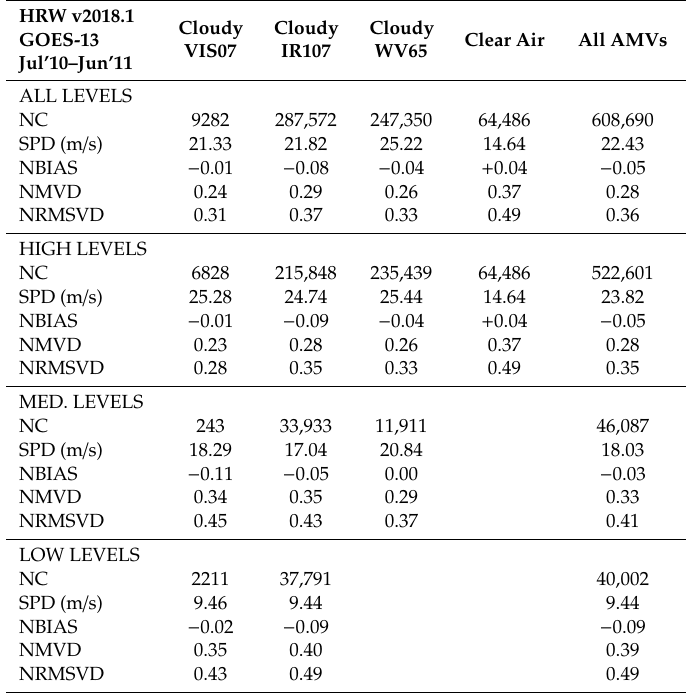
Table 6. Validation for NWC / GEO-HRW v2018.1 AMVs against radiosonde winds, considering all AMVs together and in three separate layers: high levels: 100–400 hPa; medium levels: 400–700 hPa; low levels: 700–1000 hPa (Jul 2010–Jun 2011, 05:45 / 11:45 / 17:45 / 23:45 UTC, GOES-13 satellite, continental United States region).